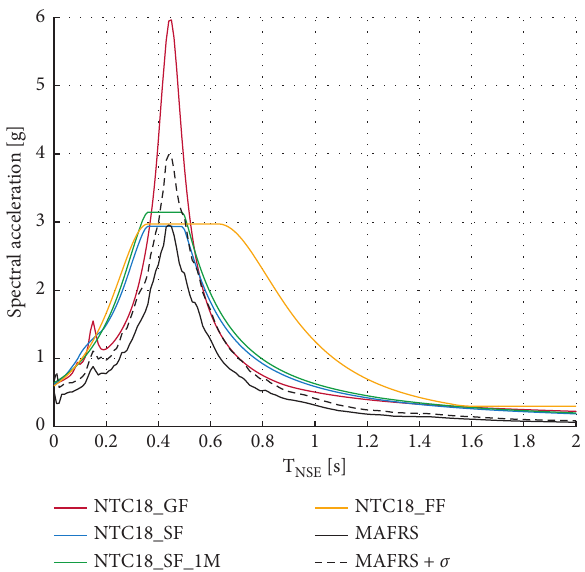
Figure 9: Comparison between NLTHA-driven AFRS and ana- lytical code-compliant